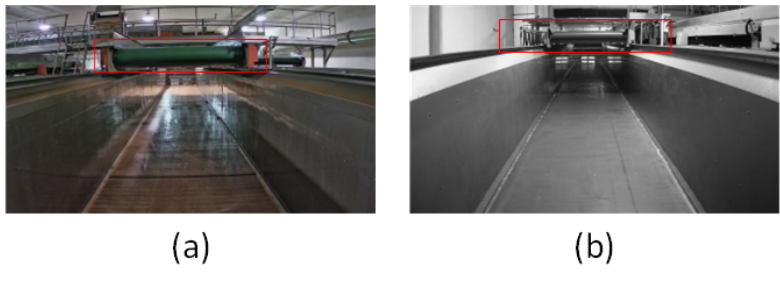
Figure 2. Feeder data. ( a ) Feeder for RGB images. ( b ) Feeder for gray images.